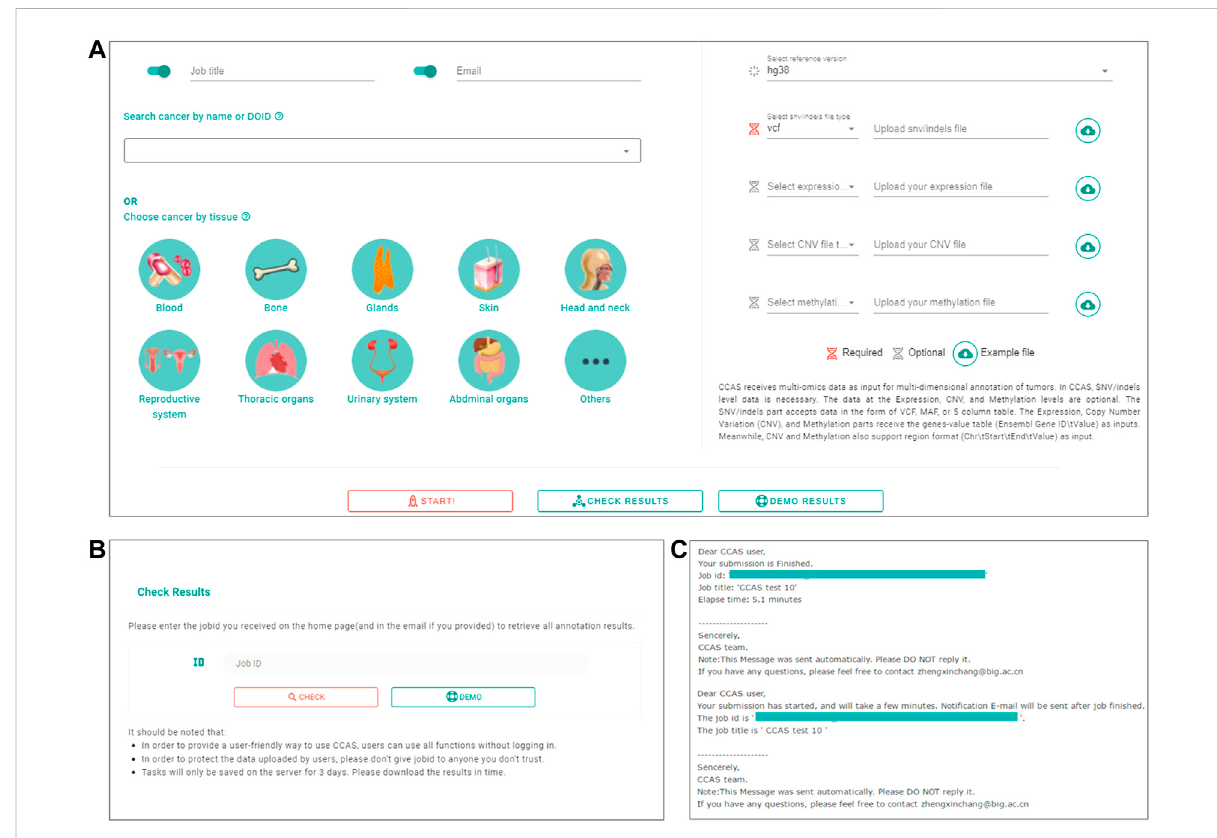
FIGURE 2 The work fl ow of submitting data and checking job progress in CCAS. (A) Submitting portal at home page. CCAS receives data at multi-omics level including SNV/Indels (required), Expression, Copy Number Variation (CNV), and Methylation along with, job title, noti fi cation email, the Disease Ontology ID, and reference version. (B) Check results page in CCAS. On this page the user can check the progress of the job. (C) Noti fi cation emails sent to users at the start of a job and at the end of a